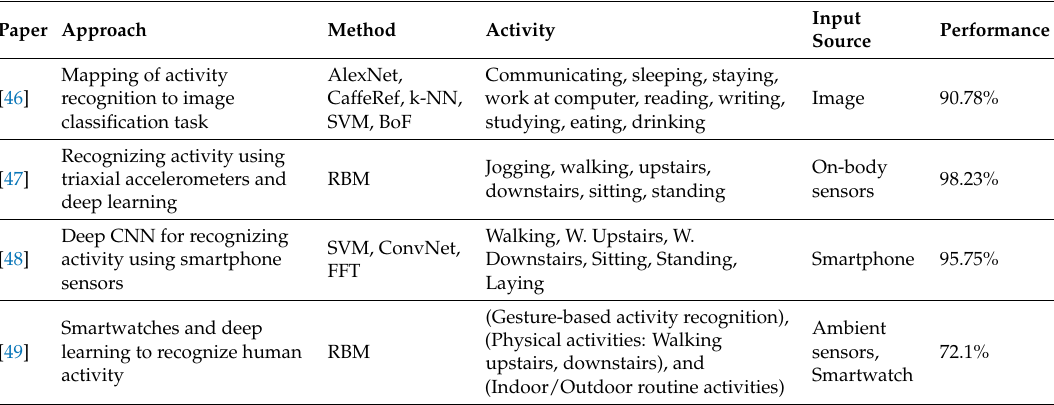
Table 2. Overview of activity recognition based on Deep Learning. SVM: Support Vector Machine; RBM: Restricted Boltzmann Machine; k-NN: k-Nearest Neighbor. Paper